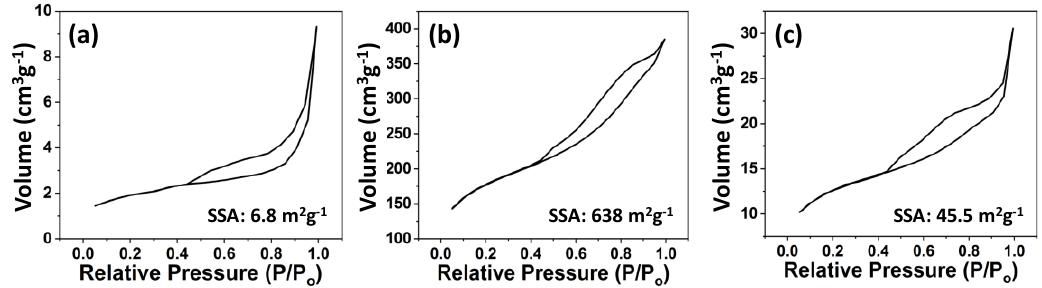
Figure 4. BET analysis of ( a ) sand; ( b ) C-MNA adsorbent material; and ( c ) mixture of sand and C-MNA used in the column.